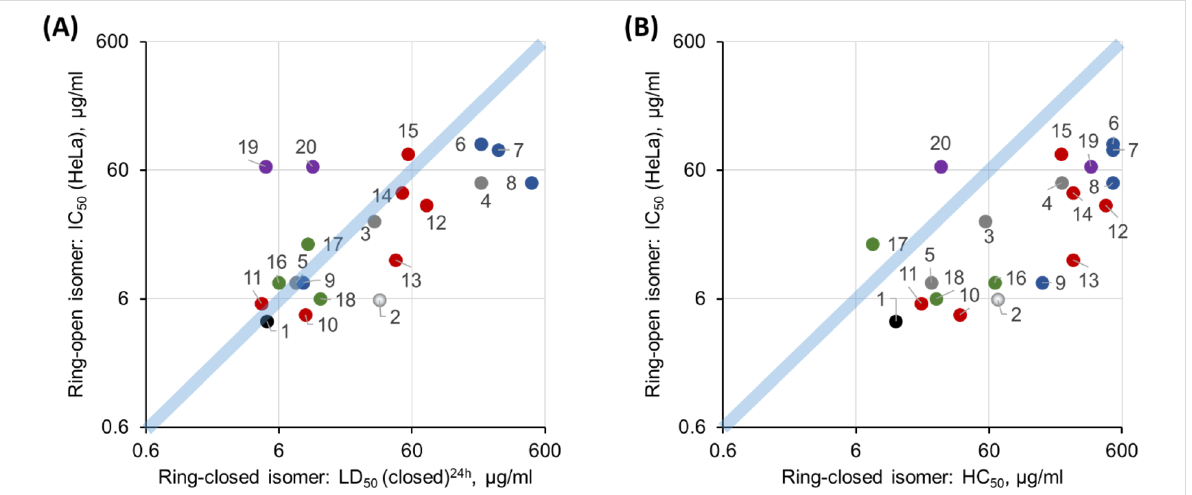
Figure 5: Phototherapeutic cytotoxic action against HeLa cells of GS 1 and its photoswitchable analogues 2 – 20 , correlated with the new in vivo results and earlier in vitro data. For each peptide, the HeLa cytotoxic concentrations of the ring-open photoforms (IC 50 (open)) are plotted against the corresponding in vivo toxicities to D. rerio embryos (A, LD 50 (closed) 24h ), or against the in vitro hemolytic activities (B, HC 50 (closed), i.e., 50% hemol- ysis]) of the ring-closed photoforms. The compound numbers are shown next to the data points. The in vitro data is from [30]. Values for the parent peptide 1 are marked black, and a white filling highlights the initial prototype 2 . Color codes for the remaining peptides are the same as in Figure